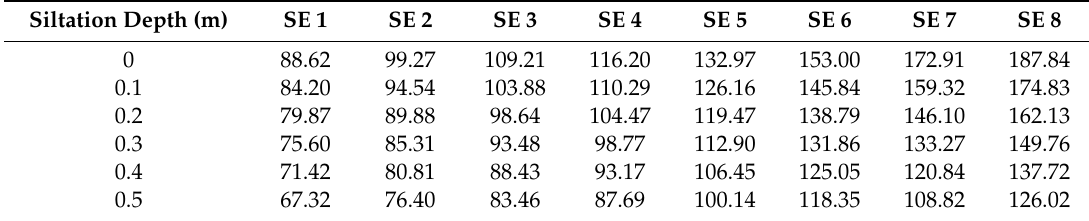
Table 9. Flood control ability (m 3 / s) for di ff erent river segments (SE) under di ff erent siltation depths.